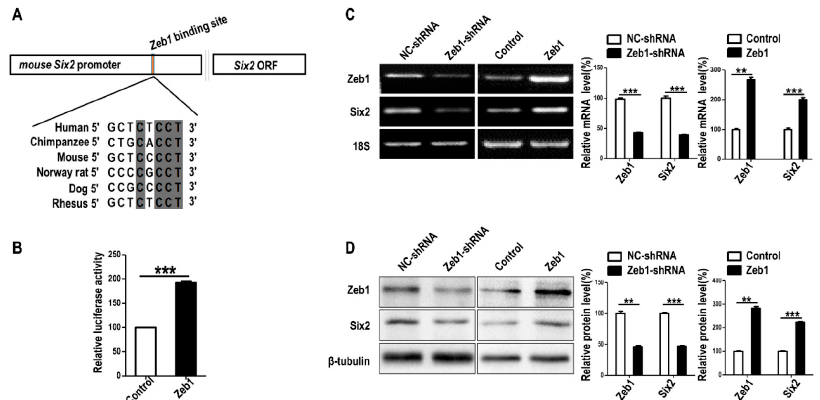
Figure 5. Zeb1 binds to Six2 promoter and up-regulates Six2 in mK3 cells. ( A ) The predicted binding motifs of Zeb1 to Six2 promoter, which was acquired from the JASPAR Database. The binding motifs across mammal species are conservatively shown in gray shadow representing the matched sequence among several mammal species, for instance, seven base pairs in eight were matched between mouse and human; ( B ) G401 cells were co-transfected with pGL-SV40 (renilla control), firefly luciferase reporter pcDNA3.1- Six2 promoter-luciferase, and either the m. Zeb1 expression plasmid pCDH-copGFP-m. Zeb1 or the respective control vector. Luciferase activity was assayed using dual luciferase reporter assay 48 h after transfection, normalized to renilla control. The result was analyzed by student’s t test and displayed with error bars representing mean ± SD ( n = 3), ** p < 0.01, *** p < 0.001; ( C , D ) RT-PCR was used to detect the expression of Six2 at both mRNA and protein level. Six2 was remarkably decreased in mK3 cells treated with Zeb1 -shRNA compared with negative control shRNA. Overexpressing Zeb1 in mK3 cells led to the promotion of Six2 expression at mRNA level. The expression was quantified by scanning gray in Image J software normalized to the internal mRNA control 18S or protein control β -tubulin. The result was displayed with error bars representing mean ± SD ( n = 3), ** p < 0.01, *** p < 0.001.